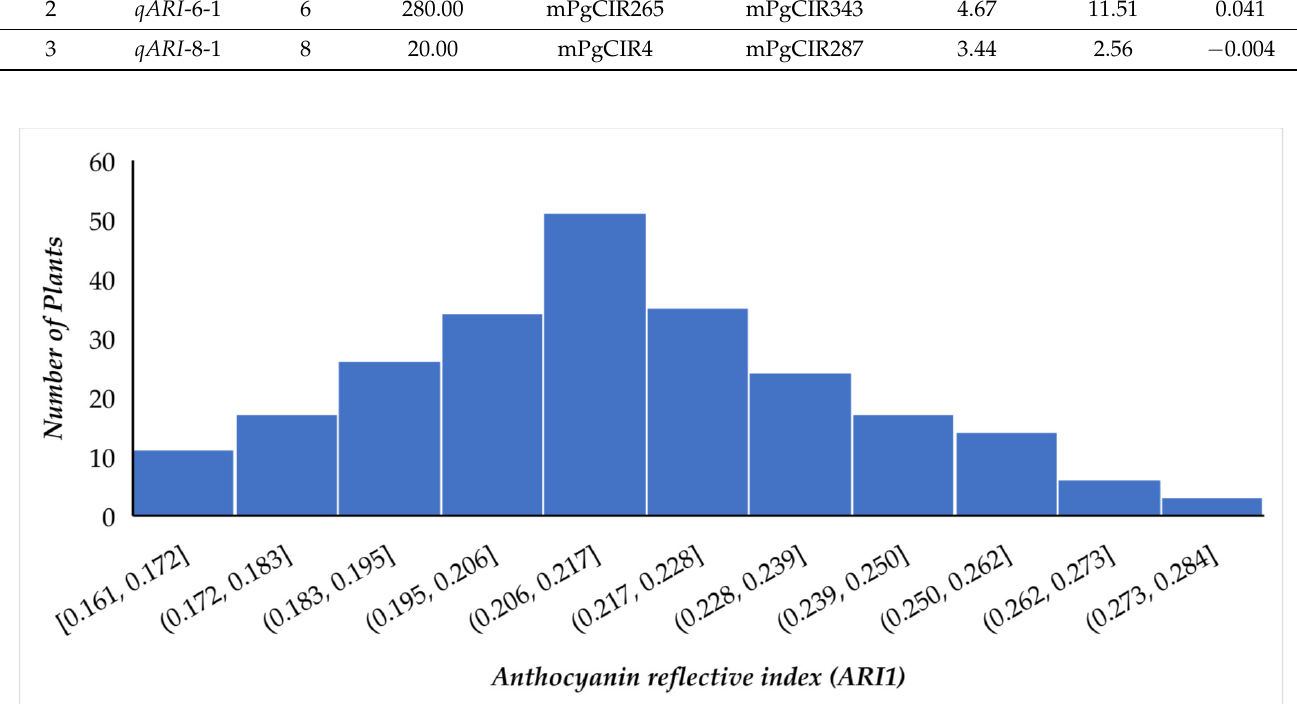
Figure 3. Phenotyping scoring of ARI1 content in F1 hybrids and their respective parents. AS = Allahabad Safeda, PG = Purple guava (local). Table 2. QTL analysis for anthocyanin reflective index ( ARI 1) using CIM algorithm.